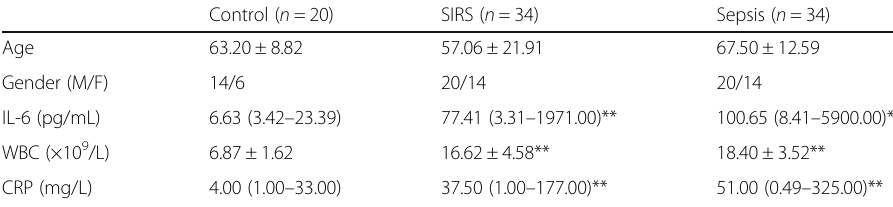
Table 1 Clinical data of patients and healthy